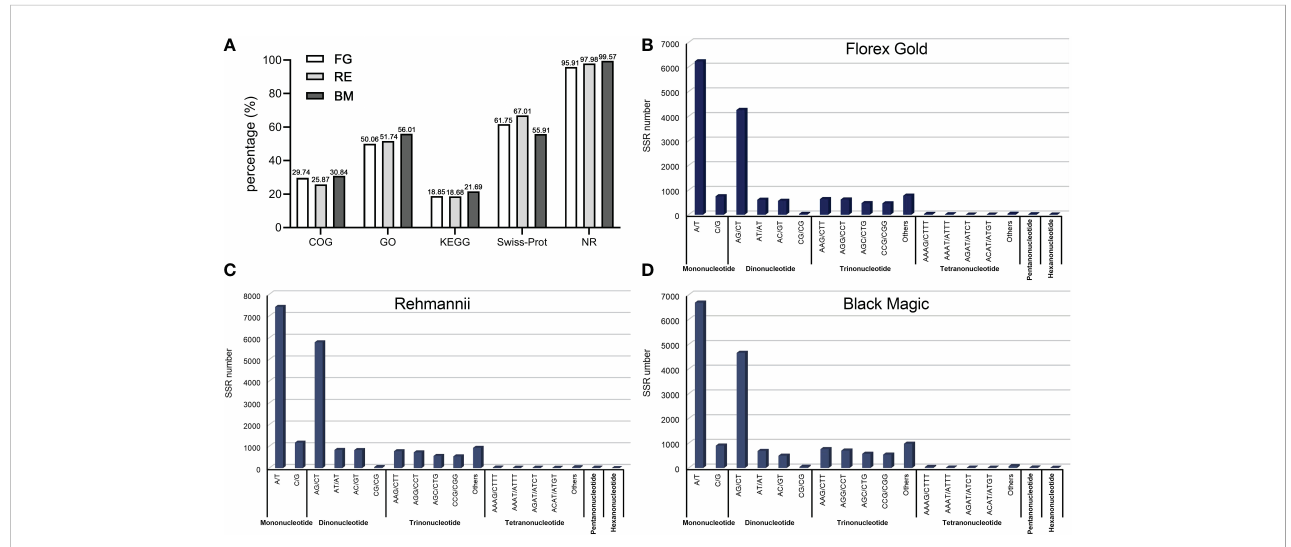
FIGURE 1 Detailed functional annotations and SSR loci identi fi cation in three varieties ’ transcriptome assembled sequences. (A) Functional annotation of unigenes of Florex gold, Rehmannii and Black Magic; SSR motif types in unigenes of Florex gold (B) , Rehmannii (C) , and Black Magic (D)